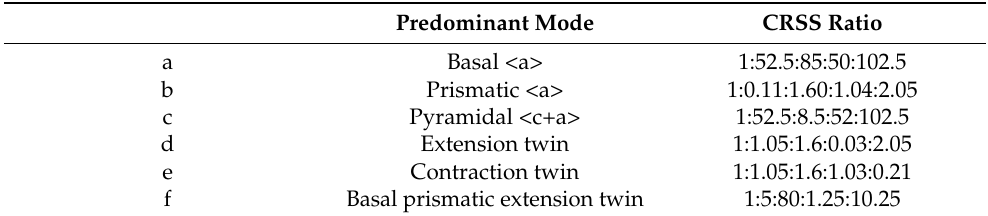
Table 2. CRSS ratio B: Pr: Py: ET: CT input in the simulations with only one slip or twinning as the predominant